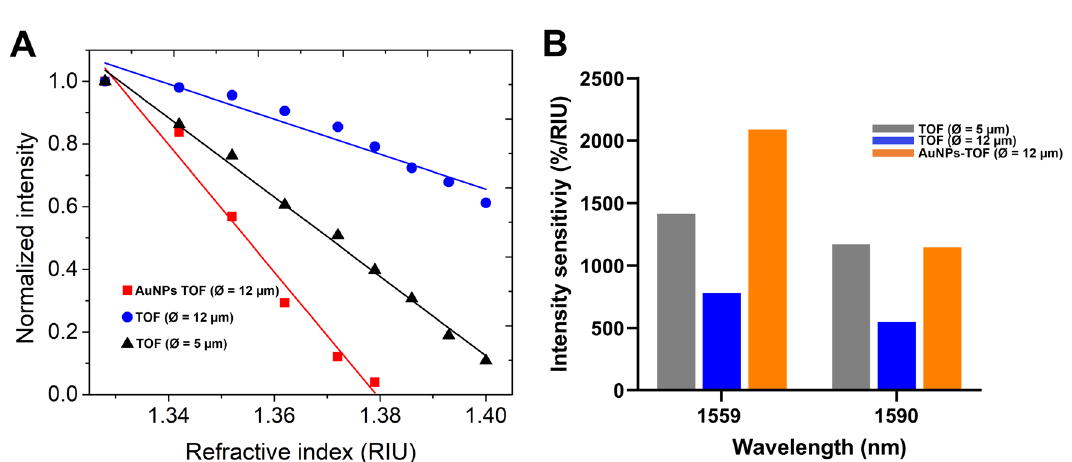
Figure 5. ( A ) Power intensity changes against refractive index of bare TOFs (red and blue) and AuNPs decorated TOF at λ = 1559 nm. ( B ) Comparison of sensitivity of TOF RI